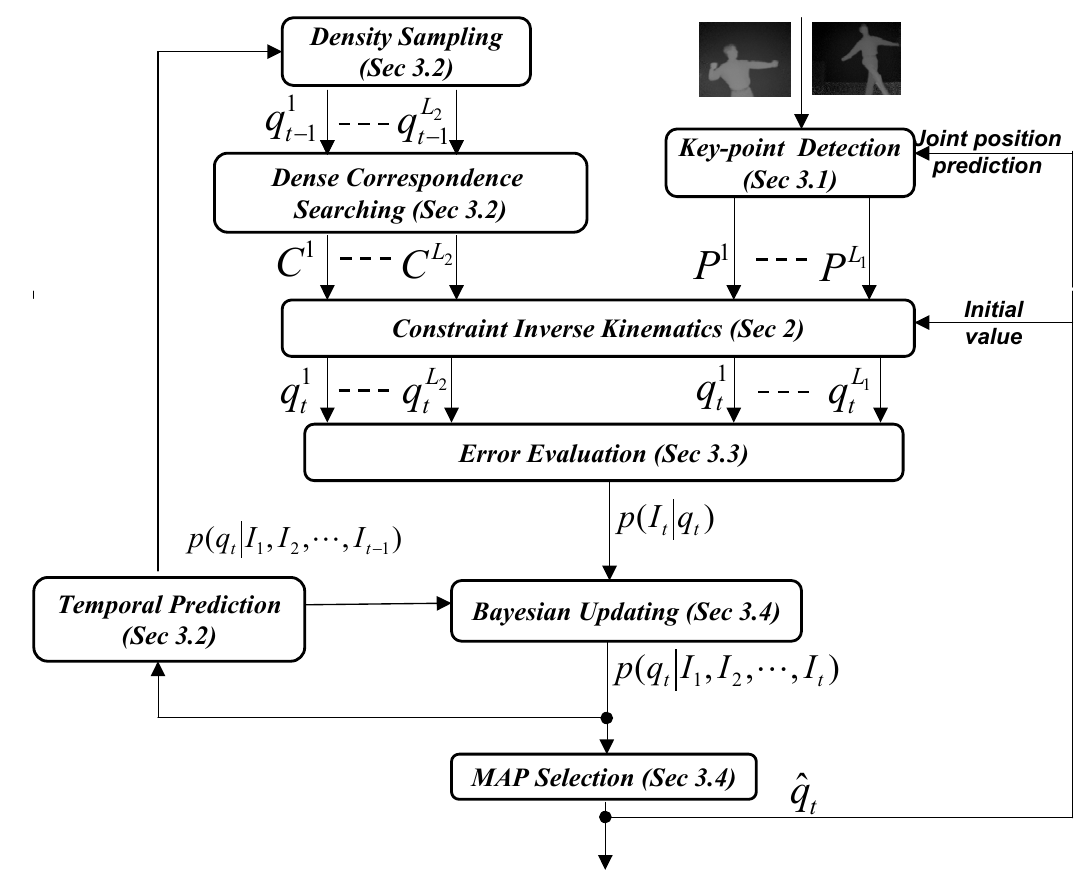
Figure 4. Robust pose estimation with Bayesian tracking